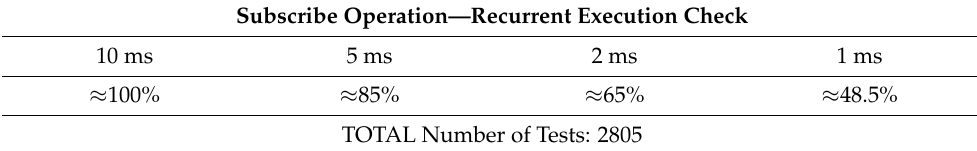
Table 3. DDS Control Node—Native Linux OS—Subscribe Operation.